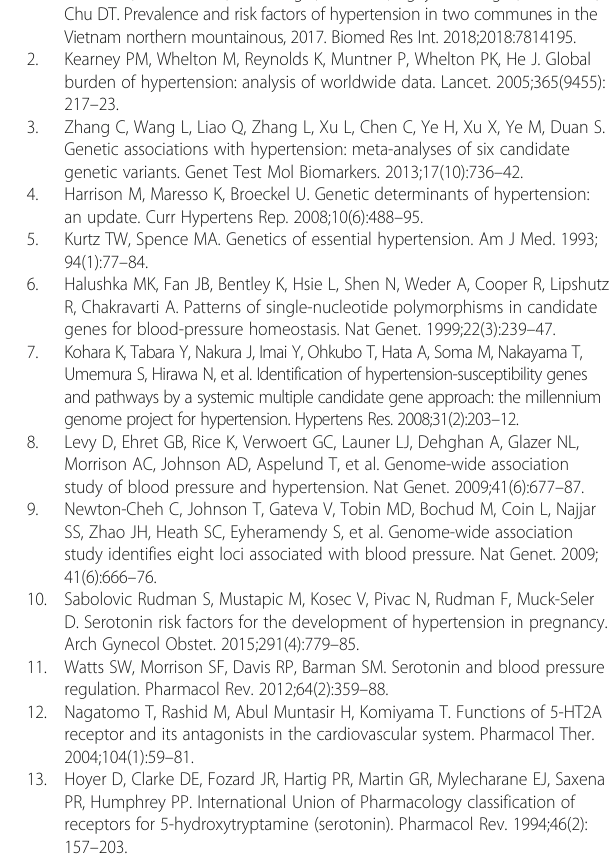
Additional file 1: Table S1. Basic characteristics of participants included and excluded. T able S2. Non-significant association of genetic polymorphisms of HTR2A gene and risk of hypertension. Table S3. Non- significant association of genetic polymorphisms of HTR2A gene and risk of hypertension. Table S4. Distribution of HTR2A genetic variations accord- ing to development of hypertension. Table S5. Association of genetic poly- morphisms of HTR2A gene and risk of hypertension. Table S6. Association of genetic polymorphisms of HTR2A gene and risk of